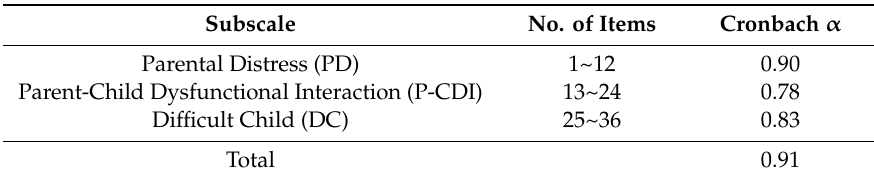
Table 1. The contents of the questionnaire (36